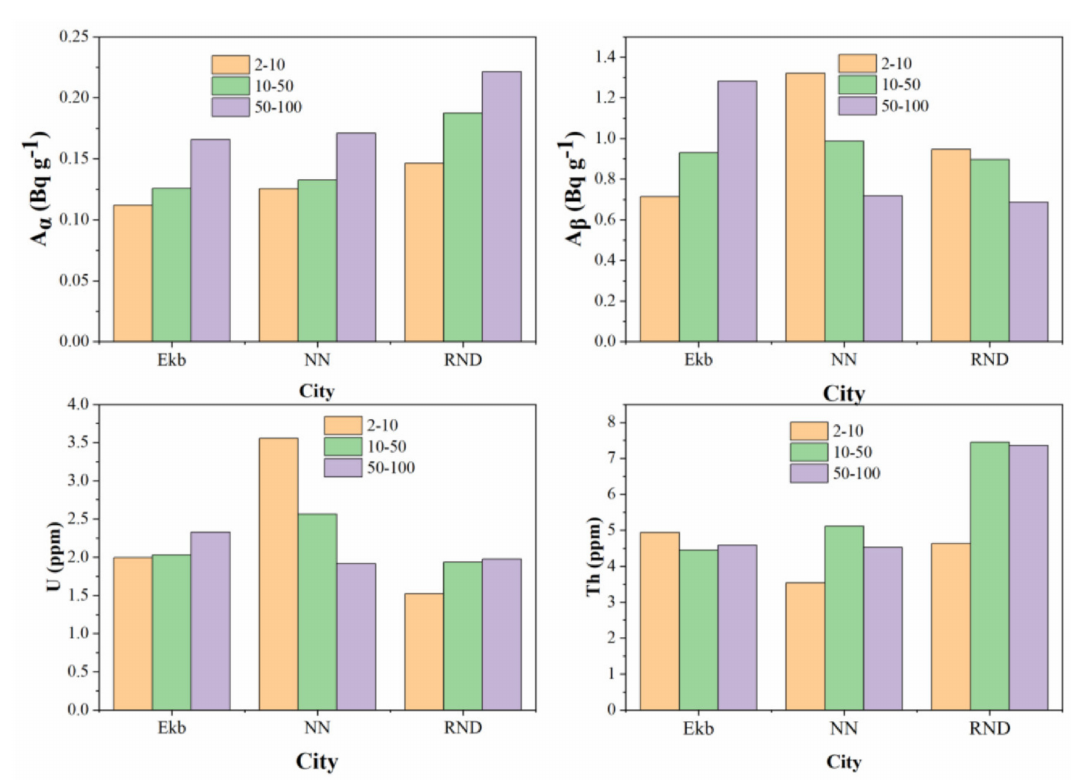
Figure 1. The variation of GA and GB within the fraction sizes 2-10, 10-50 and 50-100 µ m in the investigated Russian